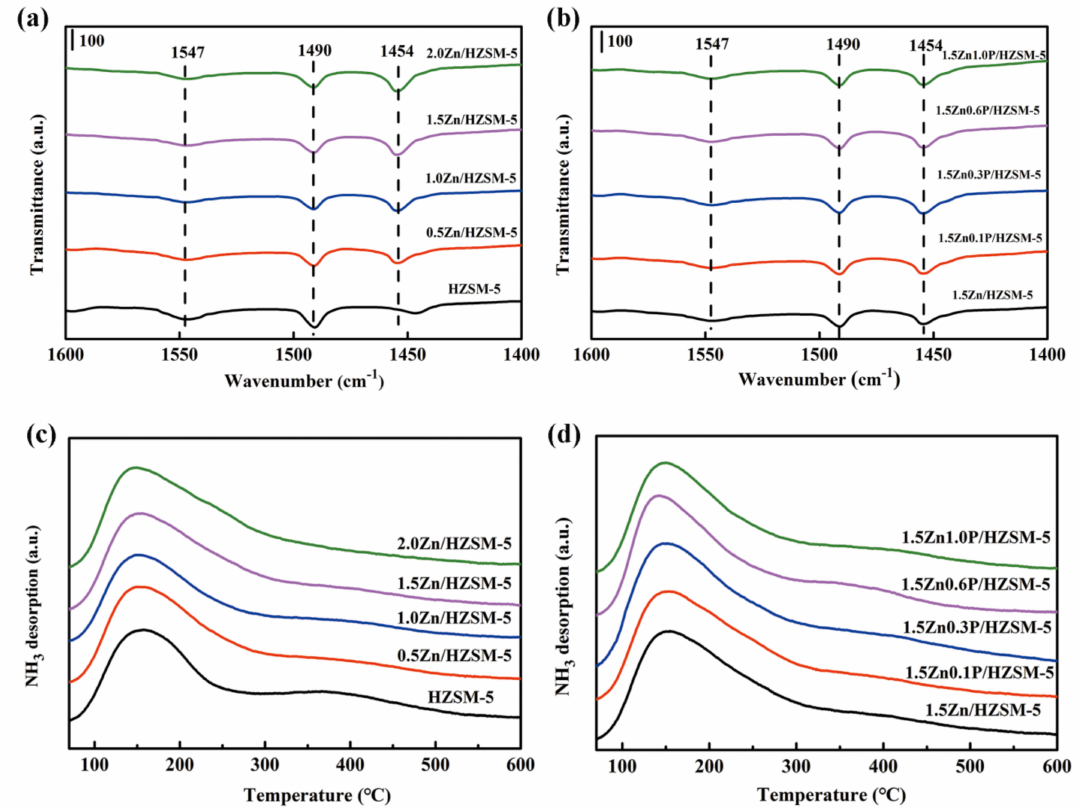
Figure 6. Fourier-transformed infrared spectrum of pyridine adsorption (Py-IR) spectra (( a ) Zn modified, ( b ) Zn-P co- modified) and NH 3 -TPD profiles (( c ) Zn modified, ( d ) Zn-P co-modified) of